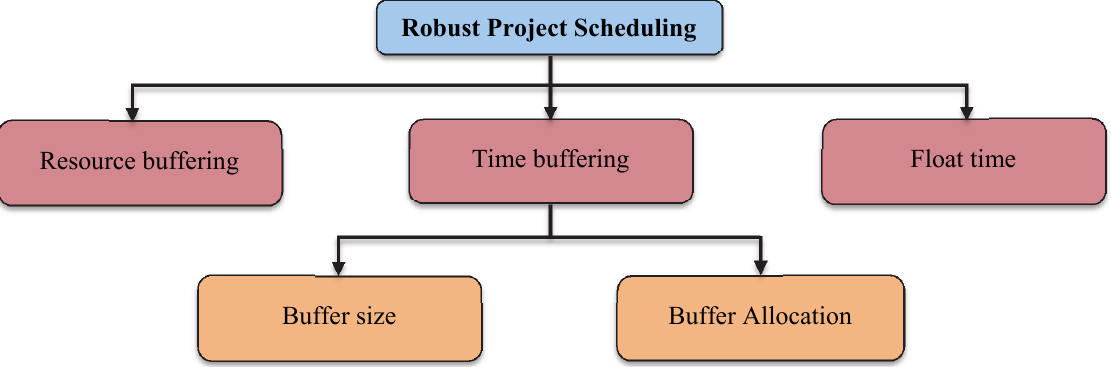
Fig. 2. Robust scheduling methodologies (Lambrechts et al.,